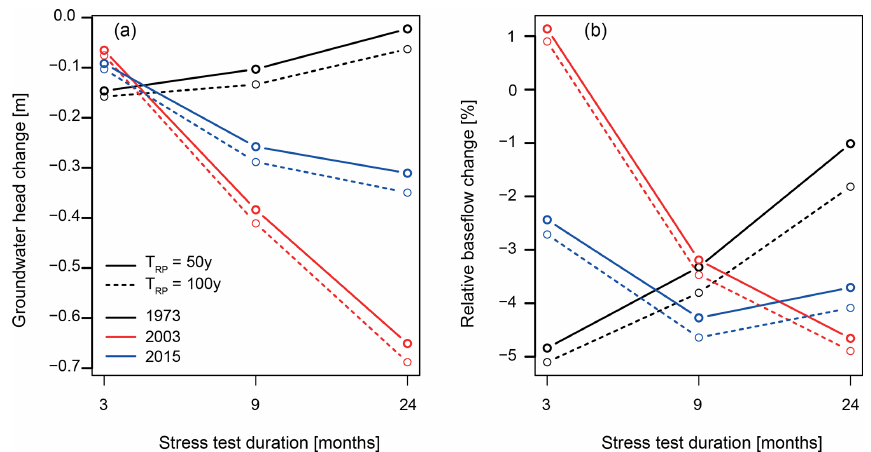
Figure 7. Changes during drought averaged over Germany for all different S EVENT stress tests: response of different events (1973, 2003, 2015), different antecedent recharge reduction timescales (3, 9, 24 months) and two return periods ( T RP = 50 and T RP = 100 years). (a) Groundwater head changes and (b) relative baseflow